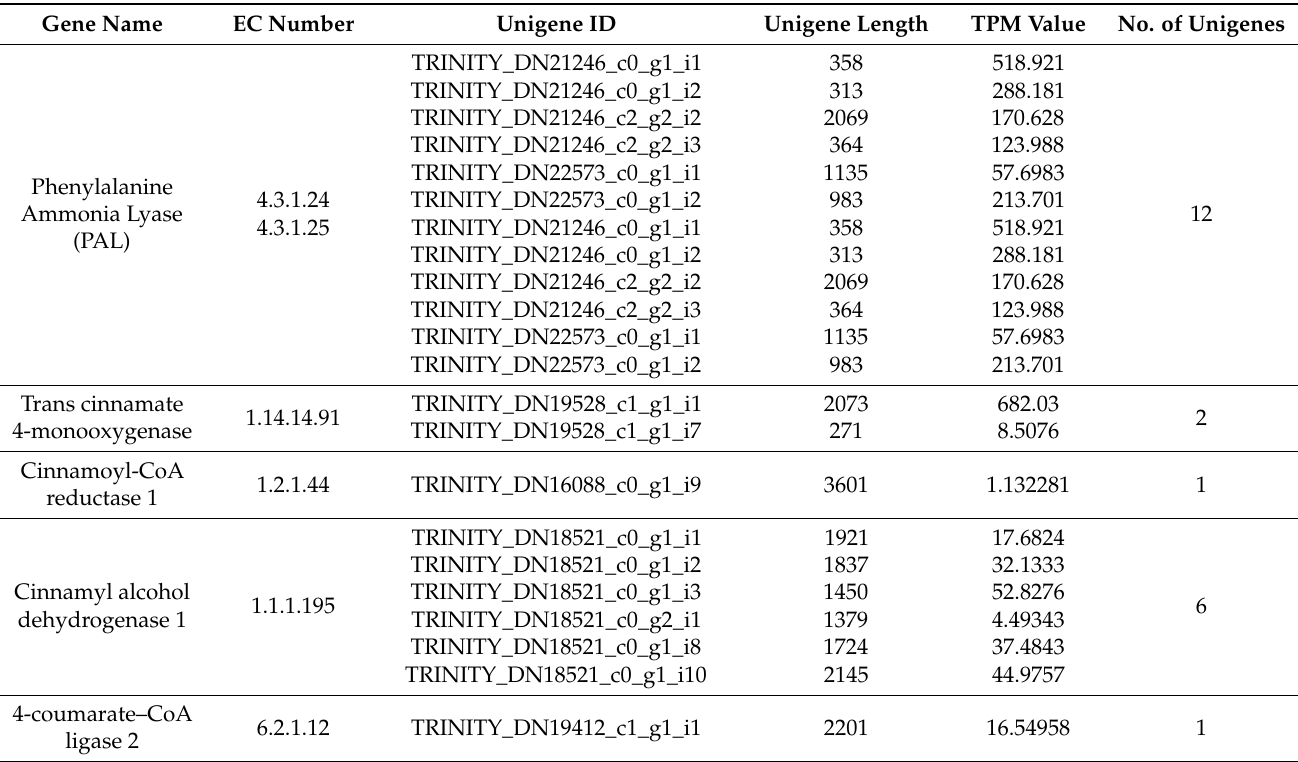
Table 3. Major genes involved in phenylpropanoid and flavonoid biosynthesis pathways identified from Sida cordifolia root